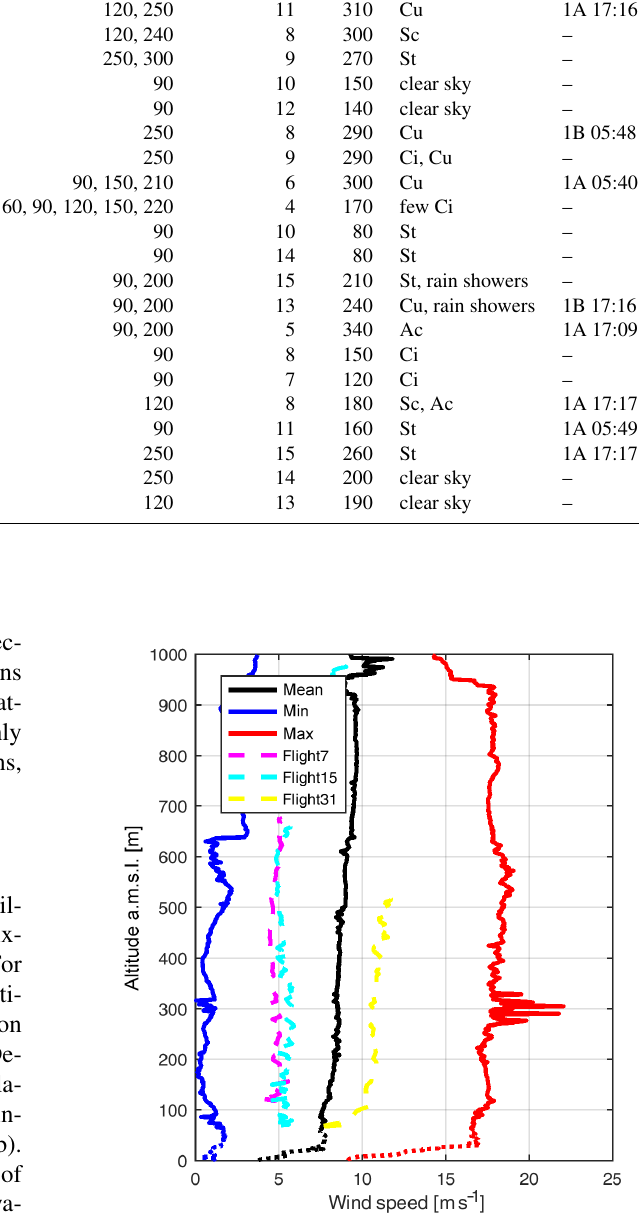
Figure 8. Average wind speed profile (black) and range of wind speed (minimum: blue; maximum: red) encountered during the 41 WIPAFF measurement flights. Additionally, the averaged profiles of flight 7 (magenta), flight 15 (cyan) and flight 31 (yellow) are in- cluded. As altitudes below 60m altitude were only performed dur- ing take-off and landing, i.e. above land and not above the North Sea, the profiles are provided as dotted